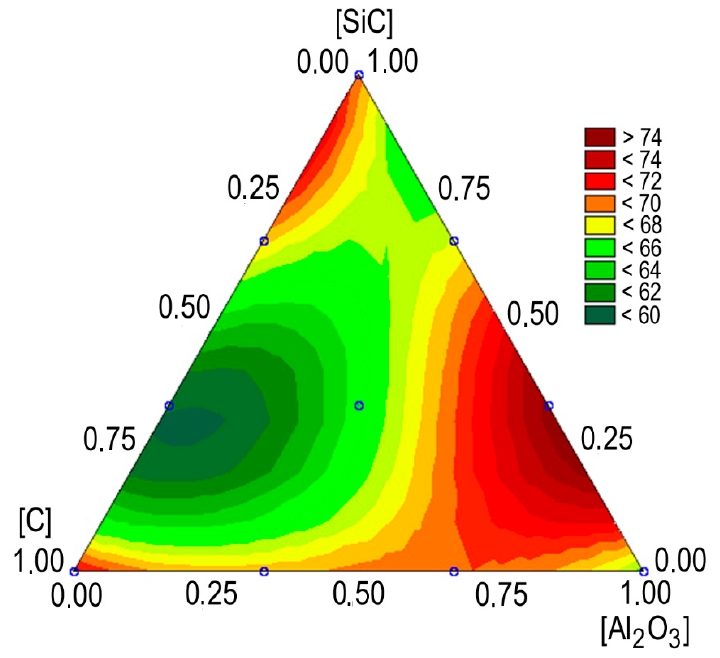
Figure 14. The effect of the MMC composition on the temperature of friction surface.